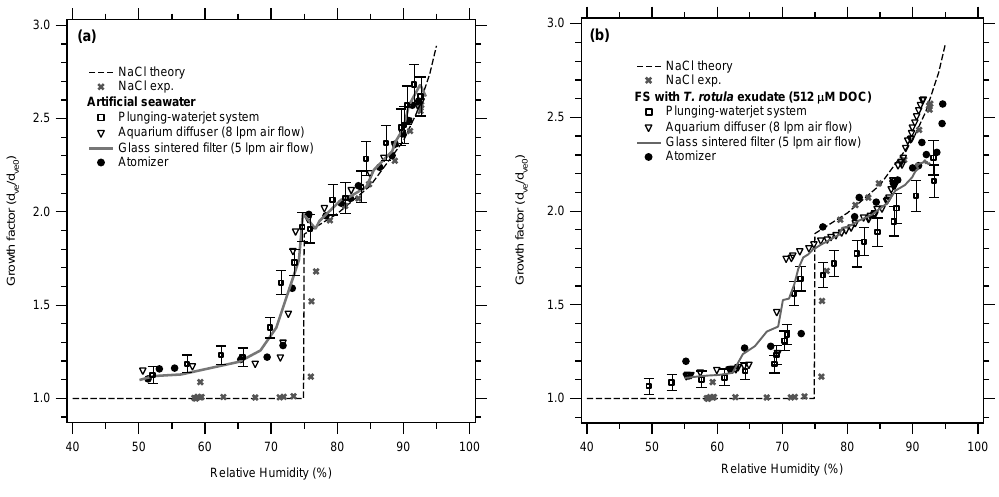
Fig. 8. Humidograms of 100nm dry particles ( d m ) generated by bubble-bursting and atomization from (a) artificial seawater and (b) FS=filtered natural seawater enriched with Thalassiosira rotula exudate (512µM DOC concentration). A shape factor χ =1.04 was applied to the presented data. Error bars indicate the uncertainty in the diameter selected by the DMA as function of the shape factor correction in the range from spherical ( χ =1) to cubic ( χ =1.08)